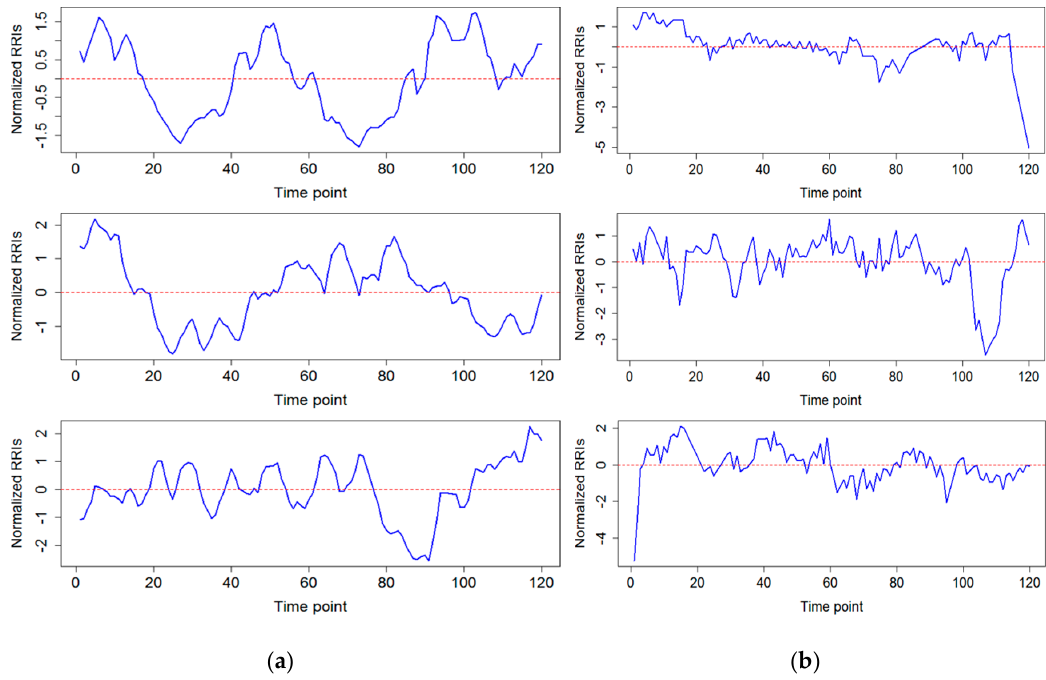
Figure 4. Some examples of 2-min R–R interval (RRI) samples obtained from an electrocardiogram (ECG) (strap) sensor: ( a ) drowsy state; ( b ) awake state.